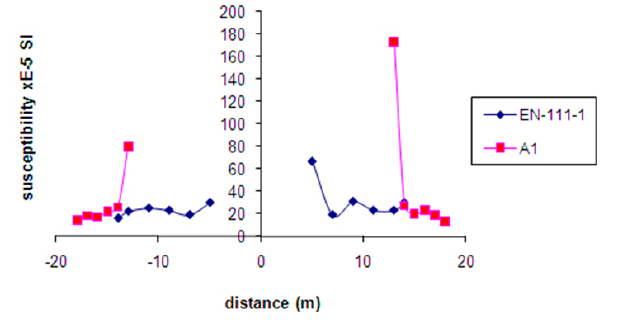
Fig. 9. Variation of susceptibility on road profiles.